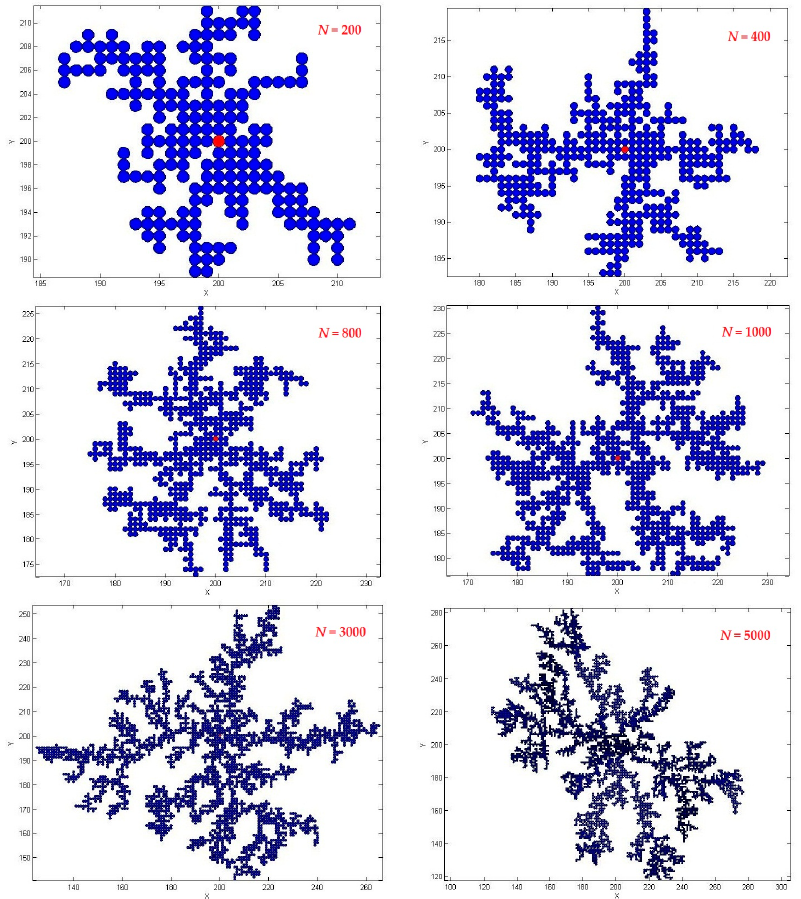
Figure 2. 2D DLA aggregates with versatile particle numbers.